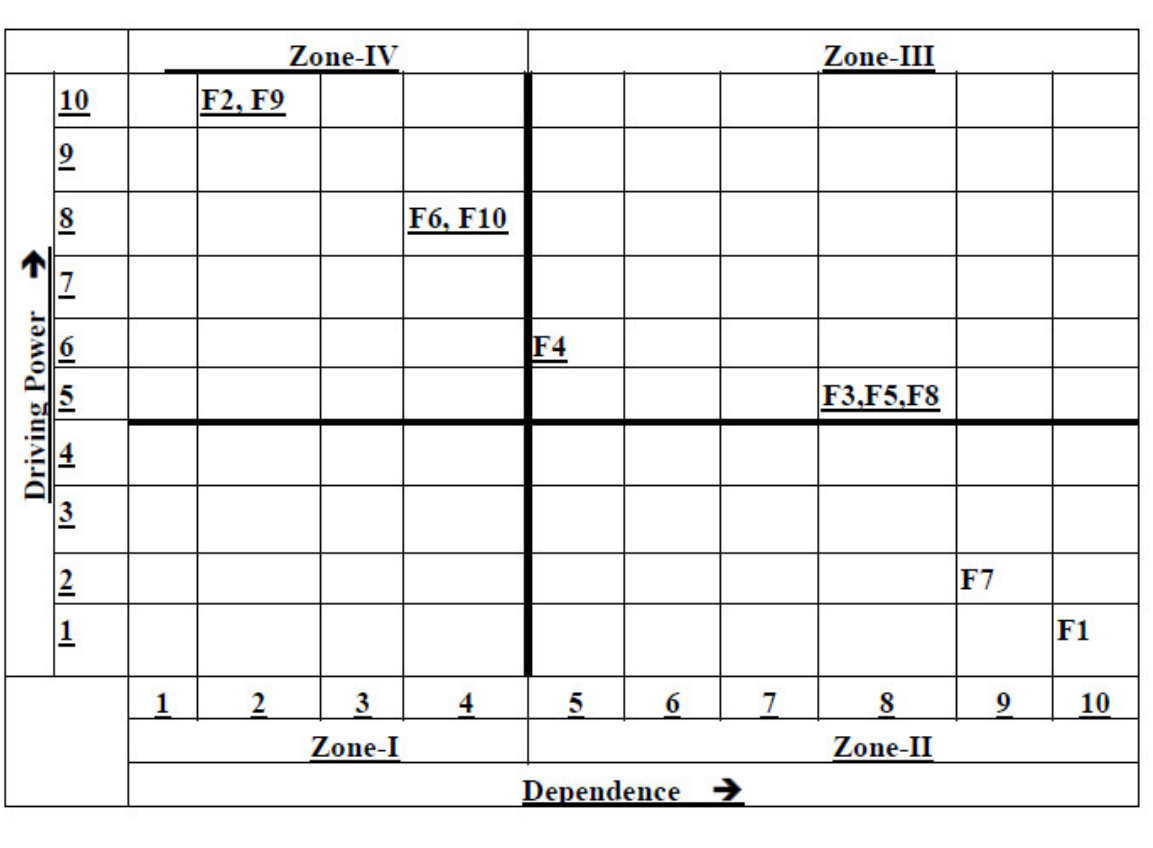
Figure 3. MICMAC